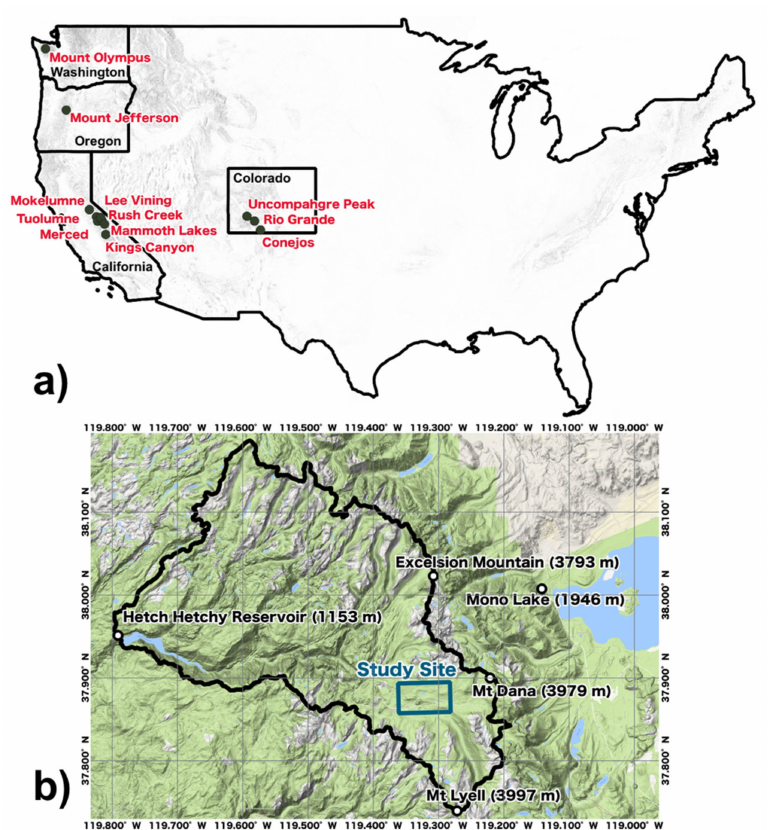
Figure 1. ( a ) Airborne Snow Observatory (ASO) coverage sites (black dots) across the US overlapped to a ASTER SRTM hillshade map. In ( b ) we focus on the Tuolumne River basin (Sierra Nevada, Central California) study site (the black polygon), which is overlapping a 10 m resolution DEM from the USGS National Elevation Dataset (NED) provided by Google Earth (Tuolumne River basin, 37 ◦ 52 (cid:48) 32.16”N, 119 ◦ 20 (cid:48) 08.85”W, http://www.earth.google.com (26 May 2014)). Well known